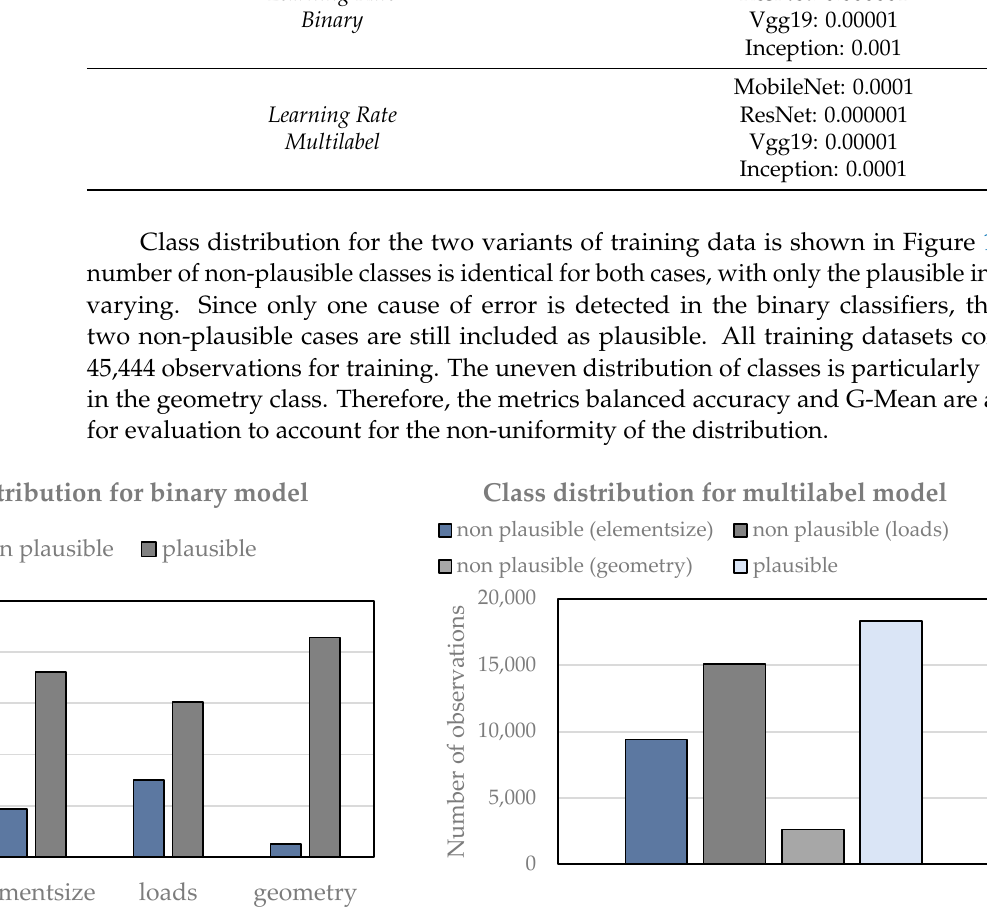
Figure 11. Label distribution for binary and multilabel models.